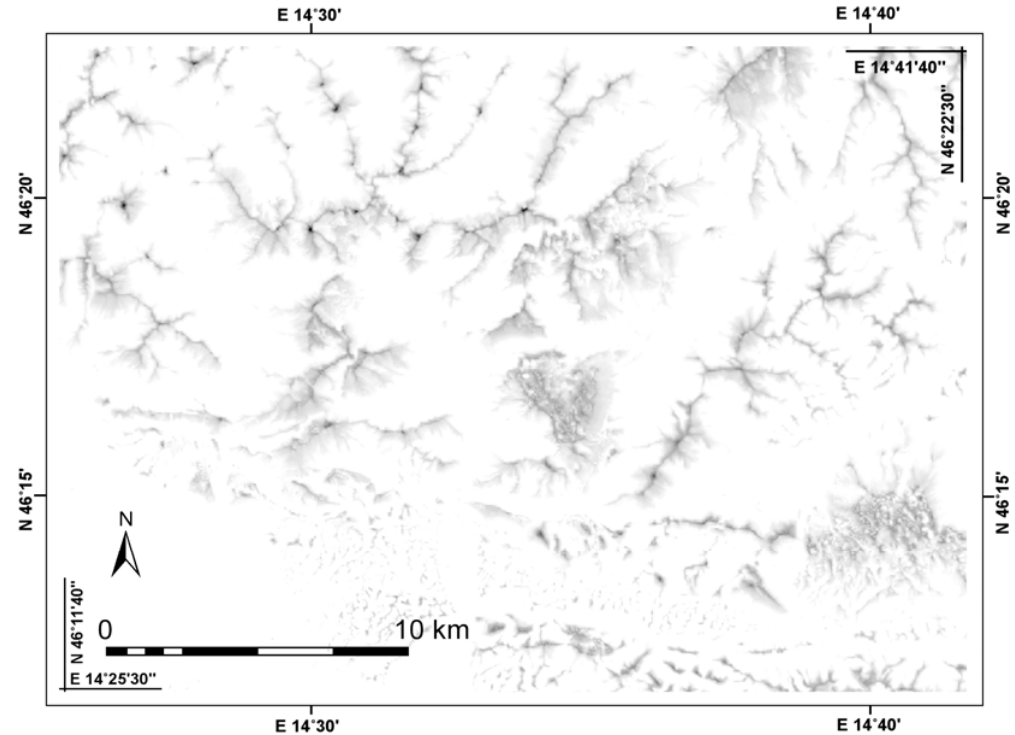
Figure 5. The potential surface for the determination of global peaks ( P potential is signified by darker